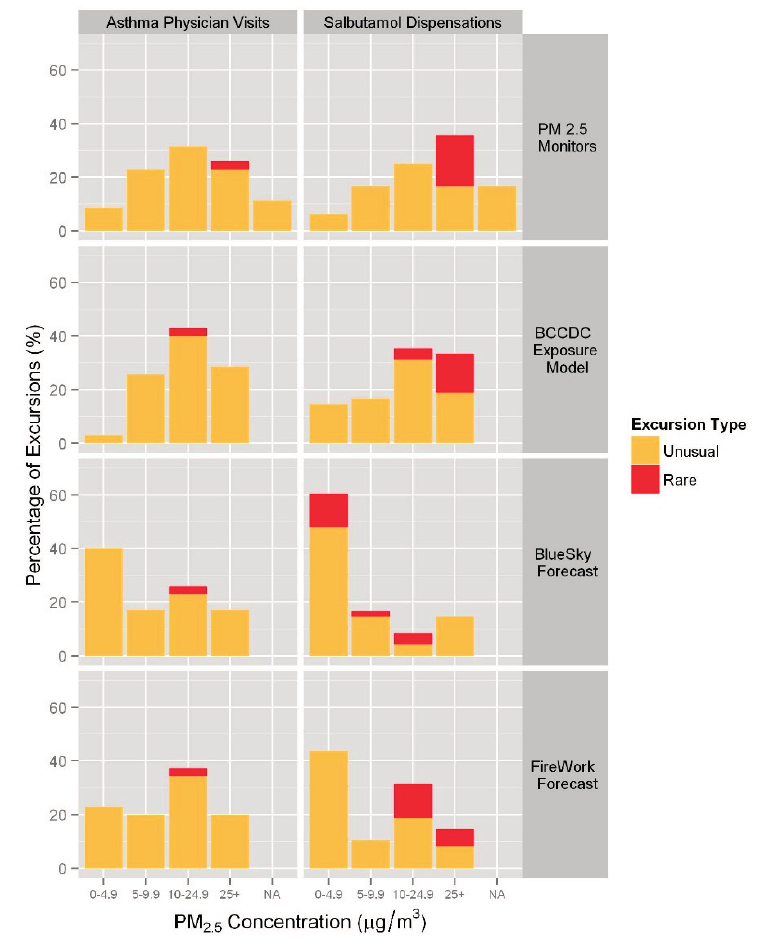
Figure 4. Percentage of excursions by highest PM 2.5 level (µg/m 3 ) within the seven-day window for each exposure